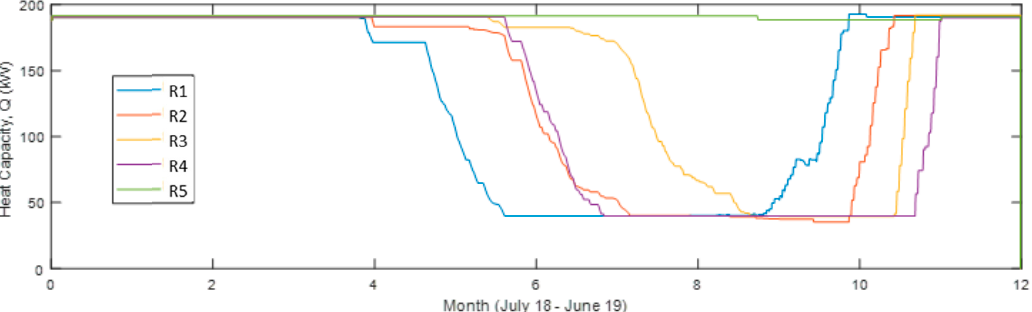
Figure 9. Heat capacity of each reactor unit 12 months from July 2018 in the simulation with four reactor units in use (Sim4).